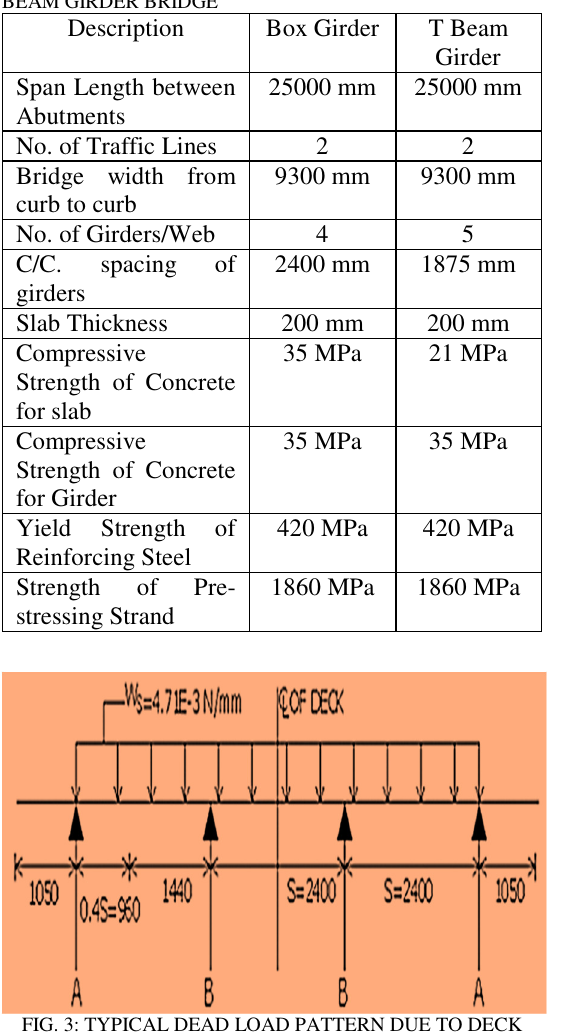
TABLE 1: GENERAL FEATURES OF SELECTED BOX AND T BEAM GIRDER BRIDGE